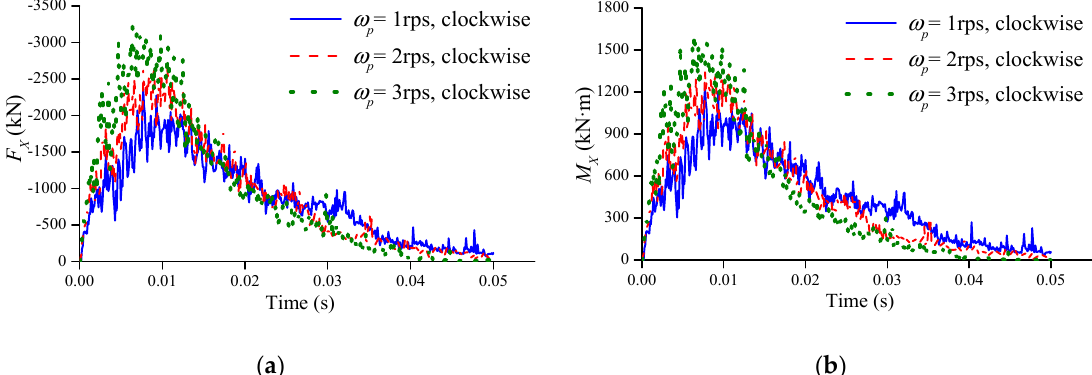
Figure 16. Time series of ice speed in the x direction based on simulations with different rotation speeds.